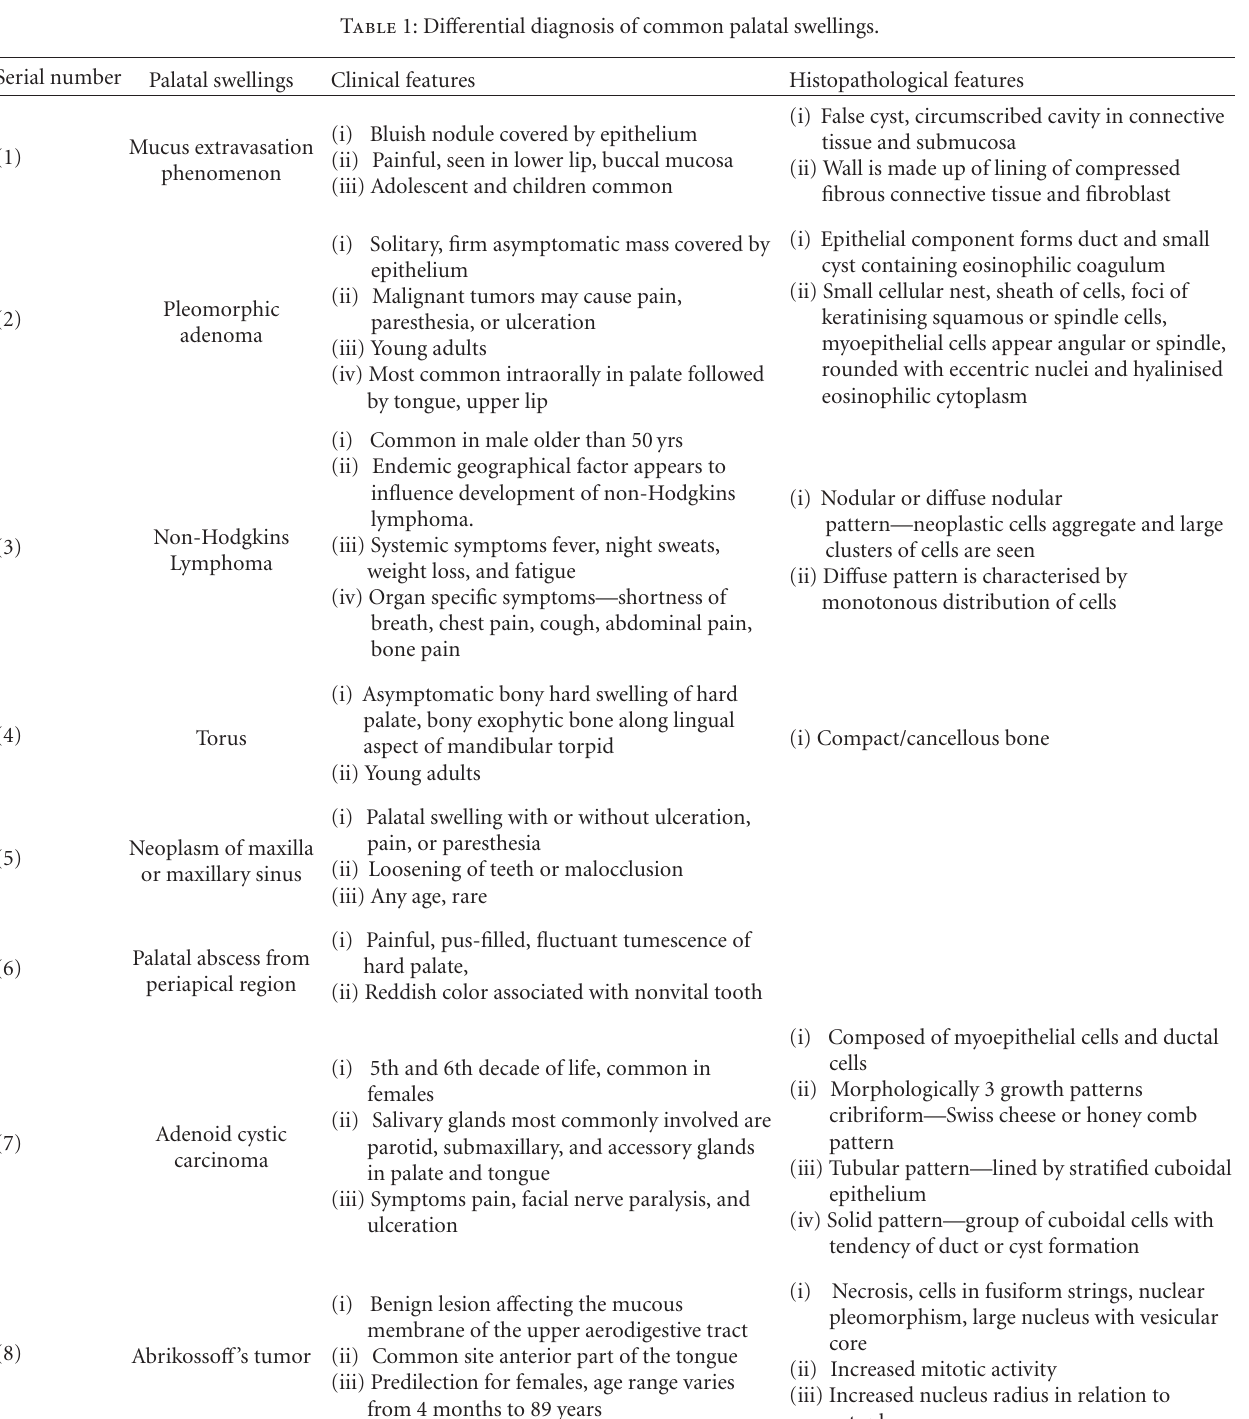
Table 1: Di ff erential diagnosis of common palatal